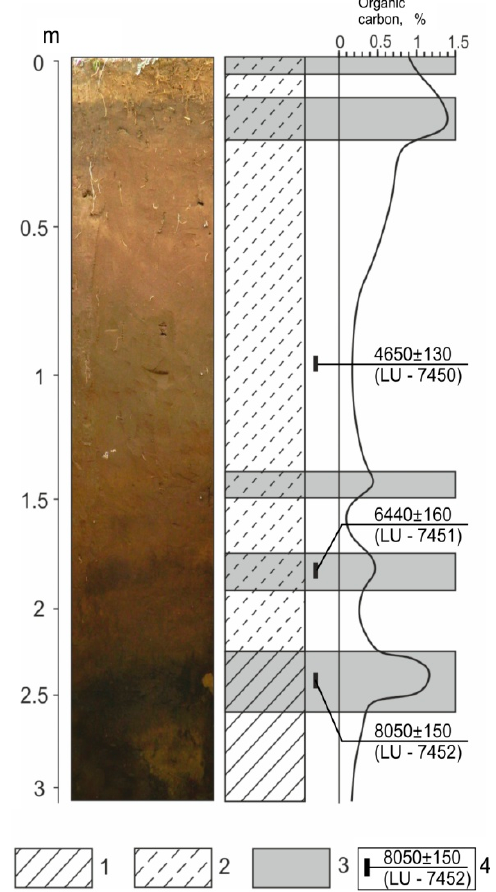
Figure 9. The structure of the Holocene aeolian deposits in the Krementui Pad’ (section no. 4). Deposits: 1 —light loam, 2 —sandy loam, 3 —humified material, 4 — 14 C sampling.